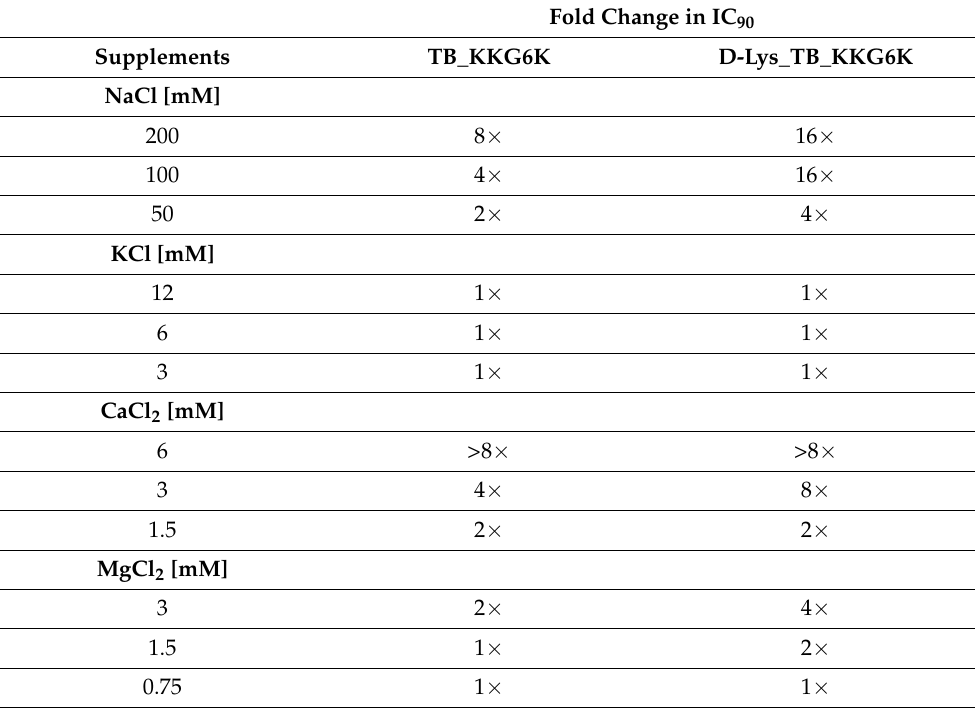
Table 4. Fold-change in IC 90 of TB peptide analogs in the presence of cations and heat-inactivated FCS §